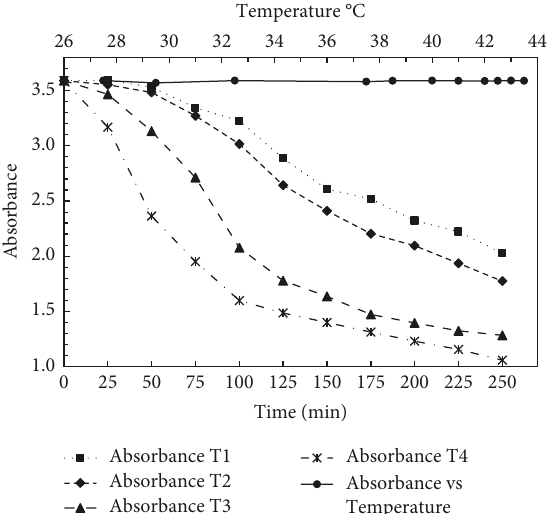
Figure 3: Change in absorbance of the diethyl (3H-1-ethoxy-3- phenoxazinylidene) ammonium chloride solution as a function of time of exposure to plasma treatment and